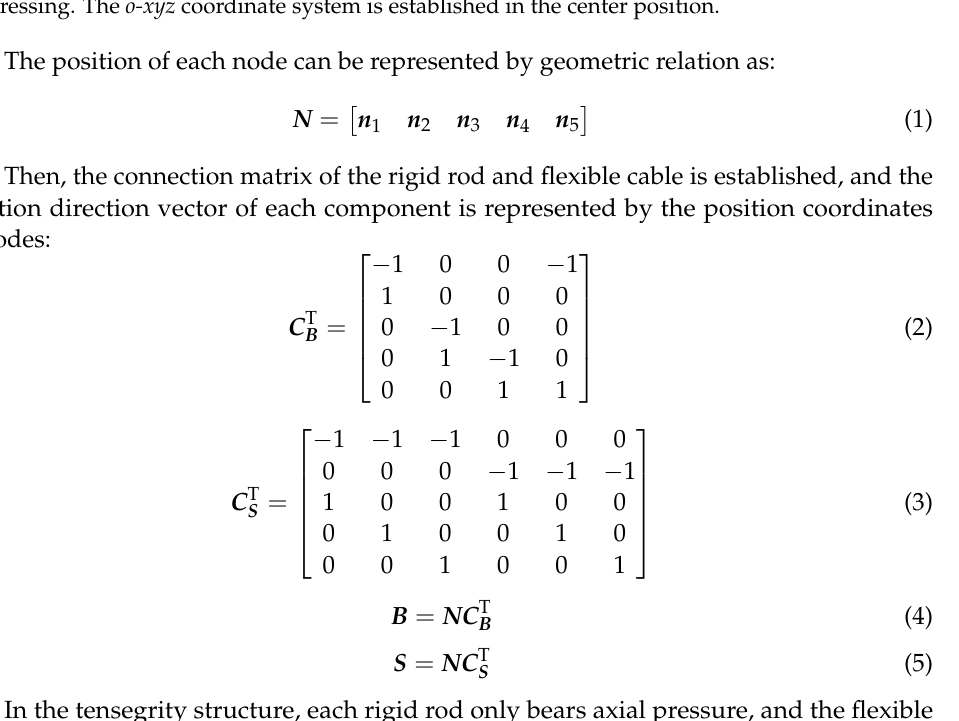
Figure 1. The trigonal bipyramidal tensegrity structure consists of six flexible cables and four rigid rods. The red line represents the rigid rod, and the black line represents the flexible cable with prestressing. The o-xyz coordinate system is established in the center position.